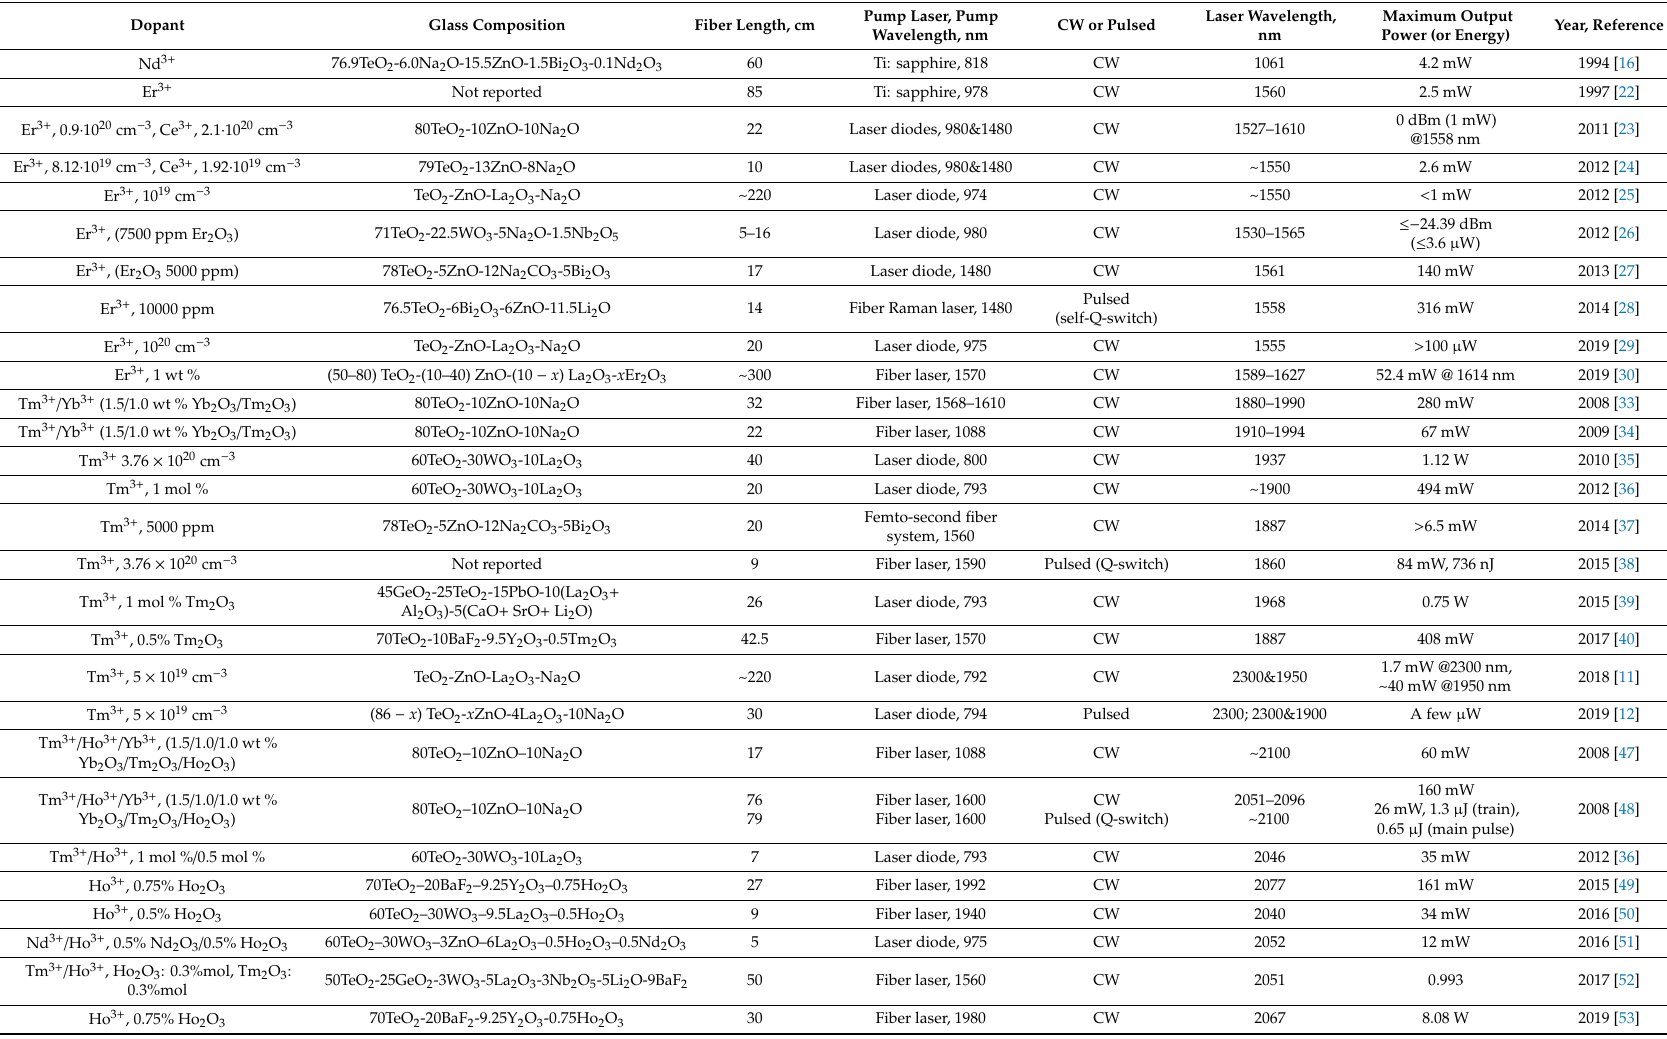
Table 1. Summary of performance of rare-earth doped tellurite glass fiber